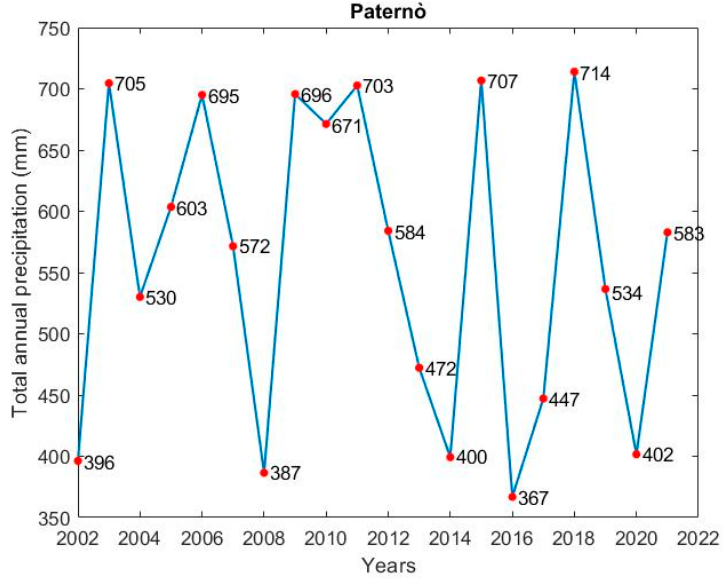
Figure 3. Trend of cumulative annual precipitation (mm) over the past twenty years (2002–2021) for the Paternò case study.